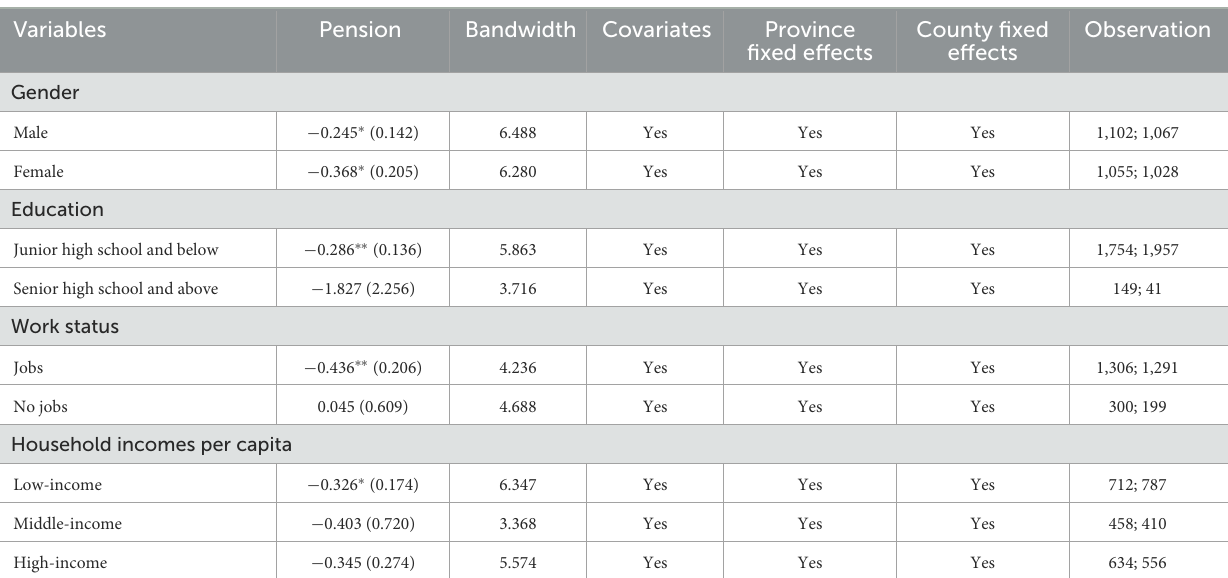
TABLE 8 Heterogeneous